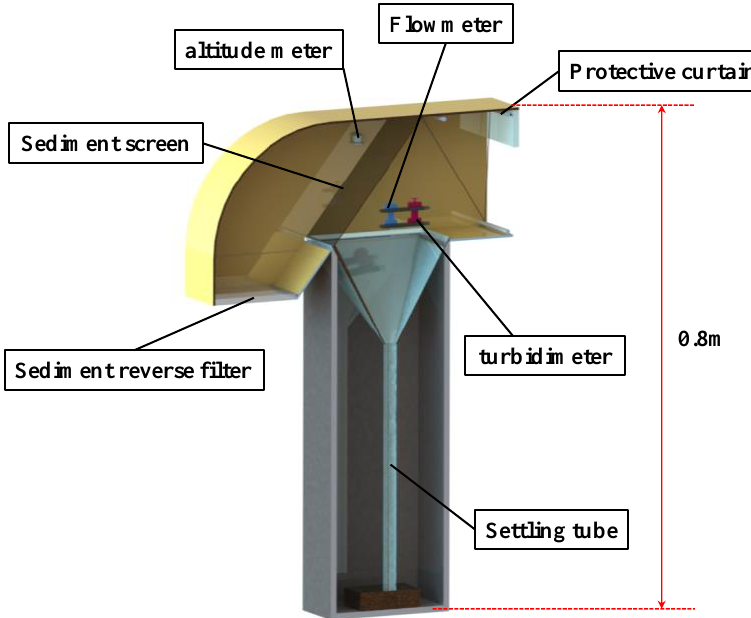
Figure 2. Structure of the capture tube.